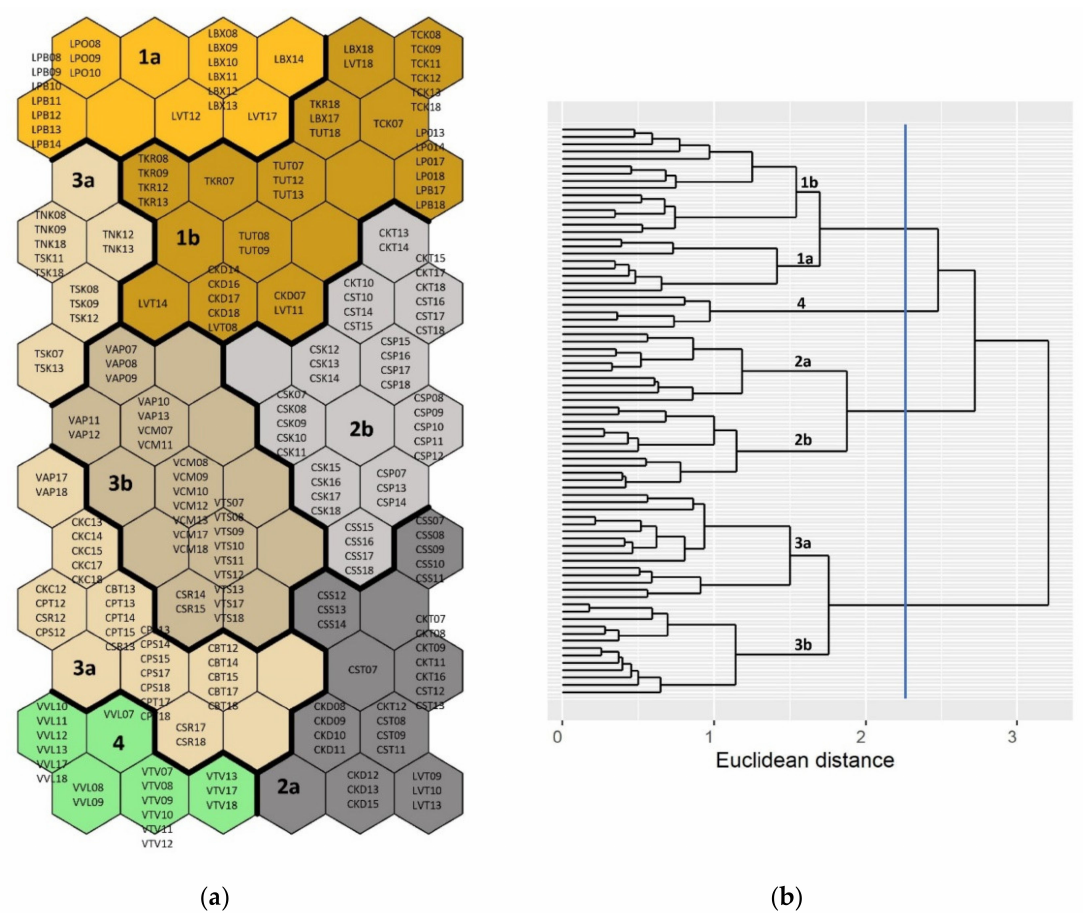
Figure 2. The output neurons of SOM with the assigned 212 samples from 25 fish monitoring sites: ( a ) SOM classification based on the similarity of fish composition; and ( b ) hierarchical clustering according to the similarity between SOM neurons. The four main groups of SOM are marked o ff by the blue vertical line. The group and their subgroups are labeled based on the longitudinal gradient of the river. Each sample is denoted by a five-character code comprising of three letters identifying the site, with the first character representing the country: C for Cambodia, L for Lao PDR, T for Thailand, and V for Viet Nam. The last two digits of the code indicate the year